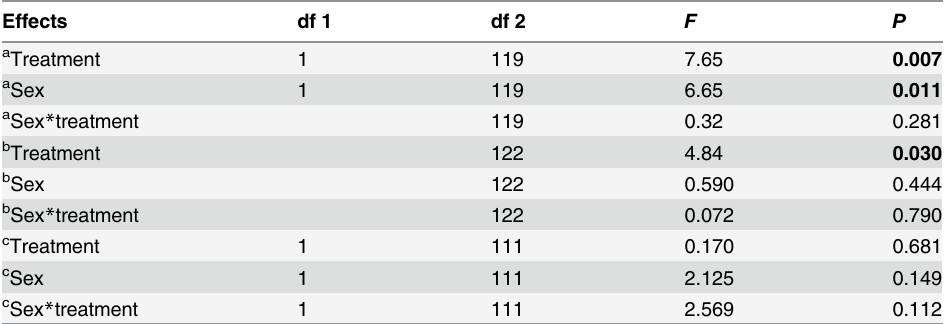
Table 5. Factorial ANOVA results of comparison of larval immune parameters between females and males reared on Betula pendula leaves with low and high concentrations of surface lipophilic